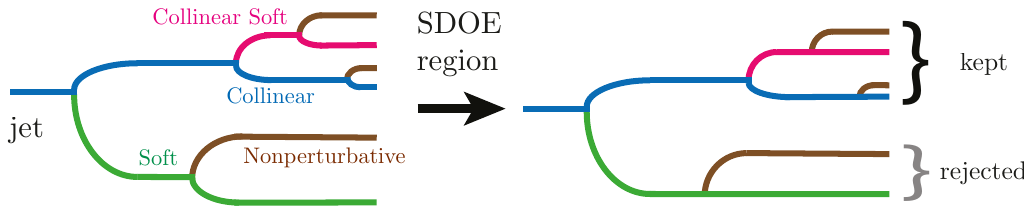
Figure 5 . Schematic of a CA clustered tree and its simpli(cid:12)cation in the SDOE region. The vertical separation between the branches corresponds to the angular distances and the CA clustering proceeds from right to left. The colors correspond to the modes displayed in (cid:12)gure 3. The angular locations of perturbative subjets in the SDOE region at leading power remain unperturbed as nonperturbative particles are